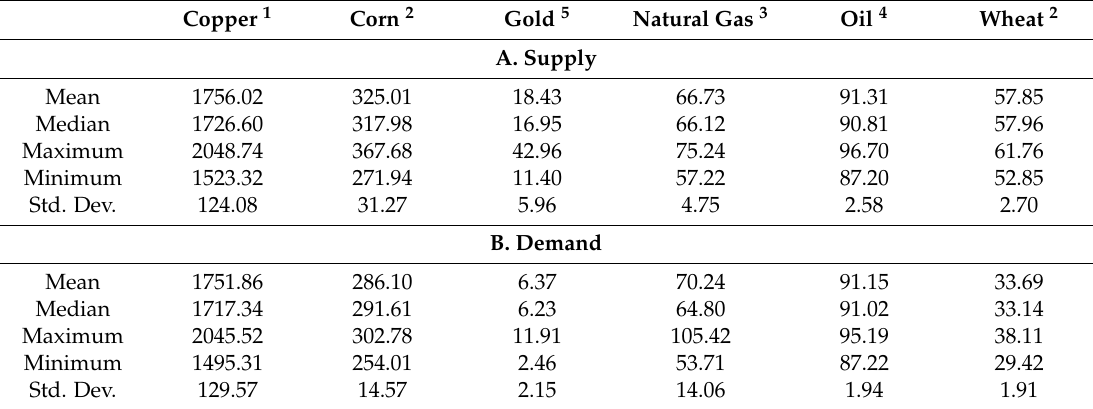
Table 3. Summary Statistics—Economic Control